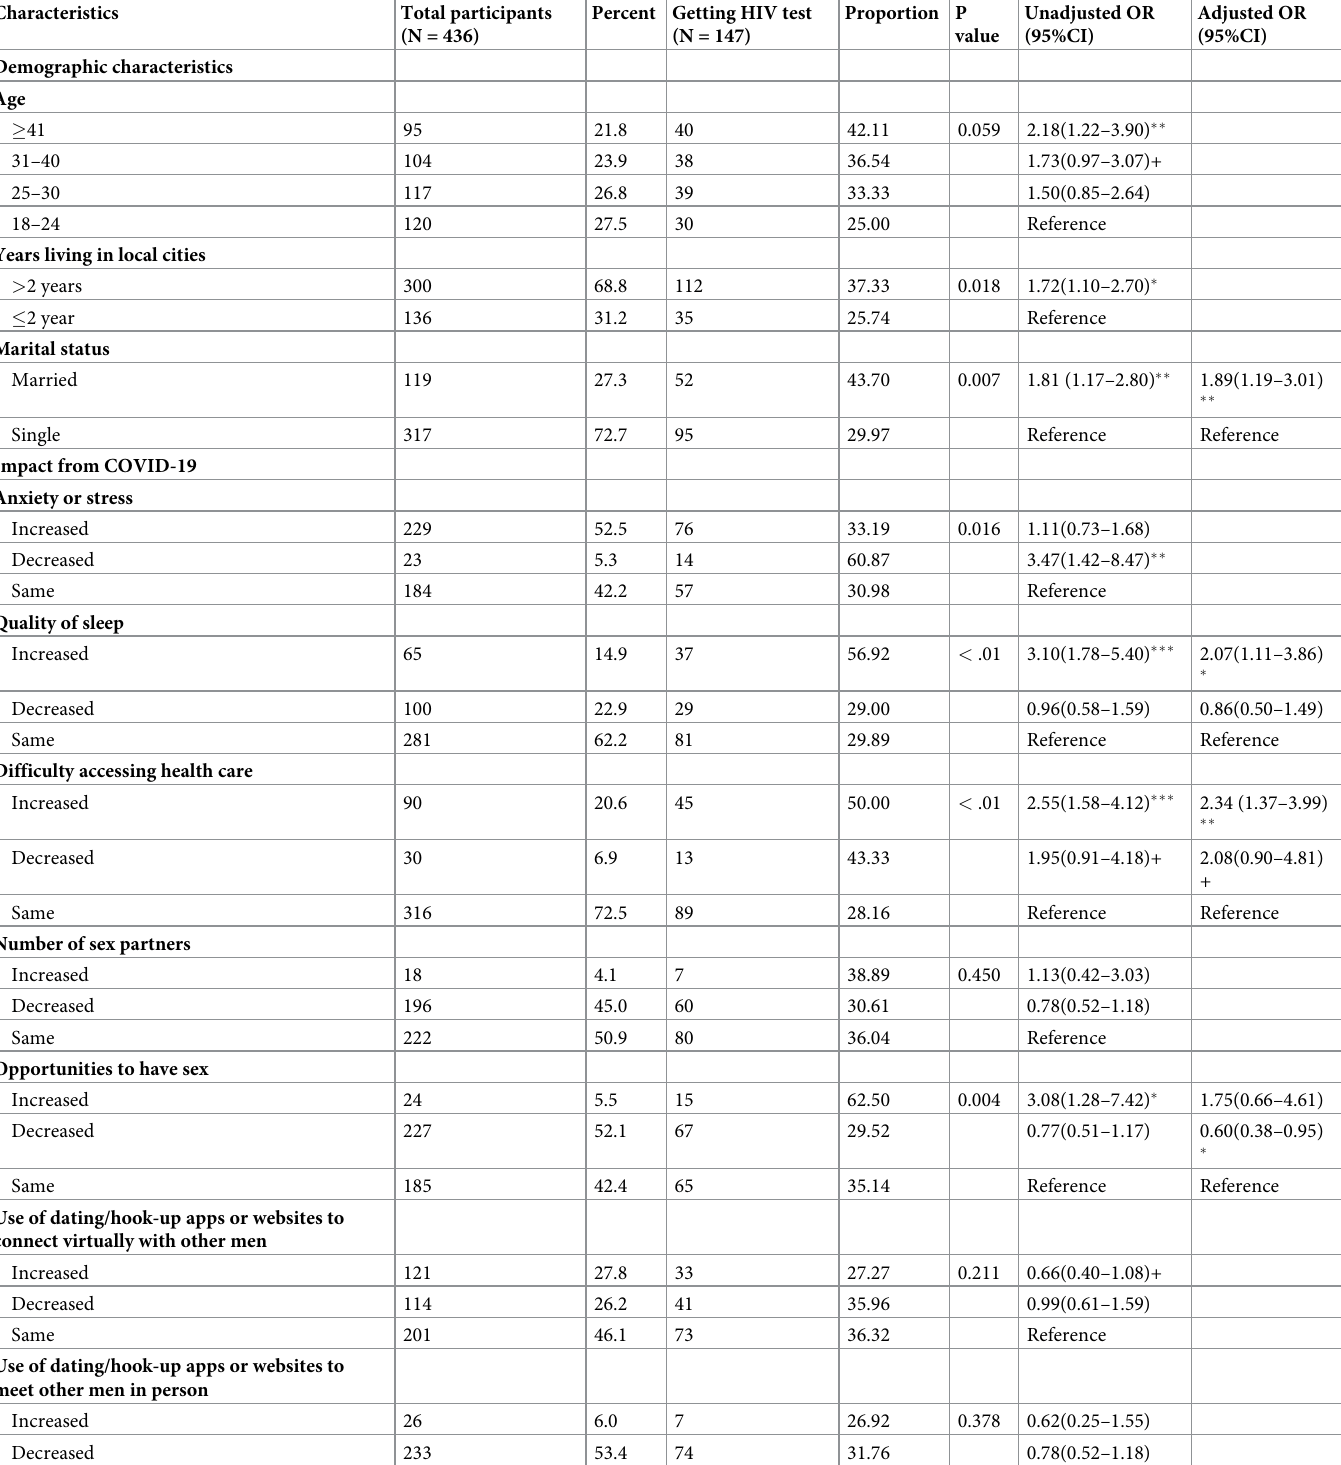
Table 2. Sociodemographic characteristics and behavioral, economic, and social impact from COVID-19 associated with receiving HIV testing during COVID-19 among MSM in Jiangsu Province, China(N = 436).